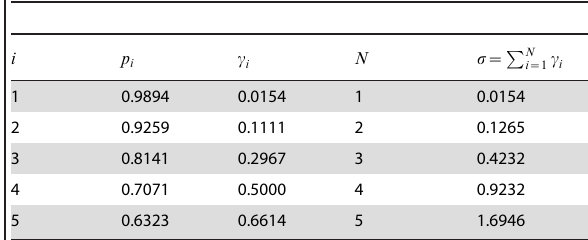
Table 3. The values of p i (Eq. (14)), c example in Figure